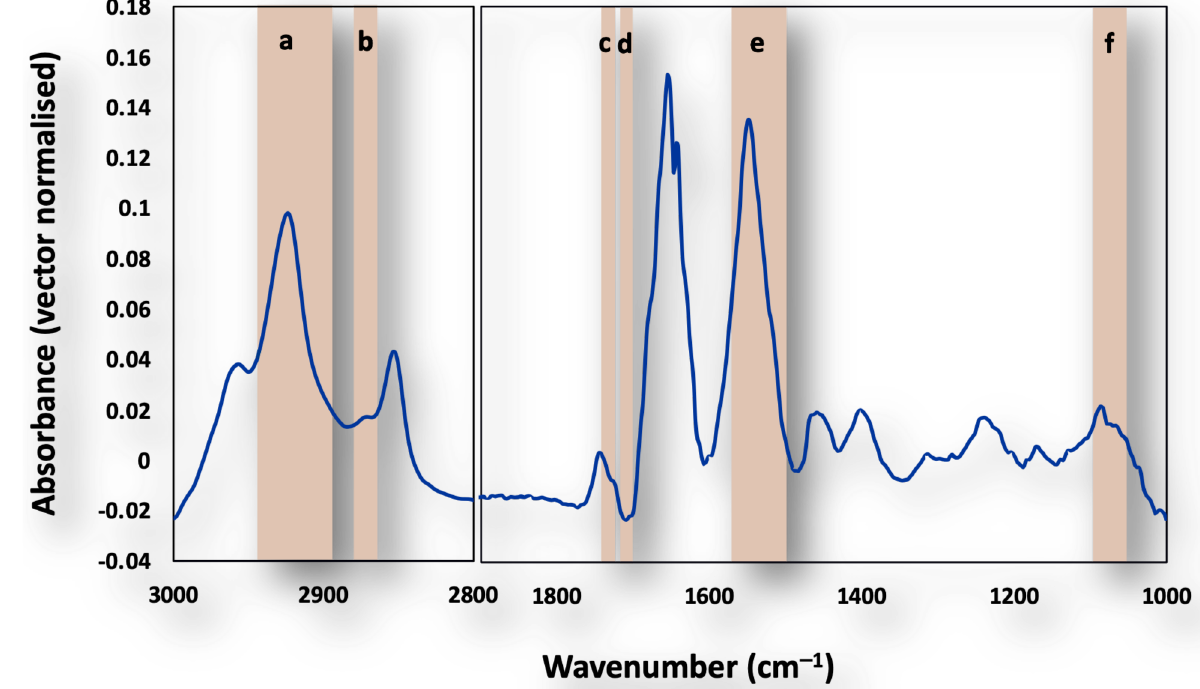
Figure 2. Typical SR-FTIR spectrum (3000–2800 cm − 1 and 1800–1000 cm − 1 ) of the cell measured through the ZnS lenses with peaks a-f used to generate FTIR images of (a) lipid ν asym (CH 2 ) (2946–2908 cm − 1 ), (b) DNA ν sym (CH 3 ) (2885–2865 cm − 1 ), (c) lipid ν (C=O) (1763–1718 cm − 1 ), (d) DNA ν (C=O) (1730–1707 cm − 1 ), (e) protein amide II (1593–1496 cm − 1 ) and (f) phosphate ν sym (PO 2 ) - (1102–1065 cm − 1 ),